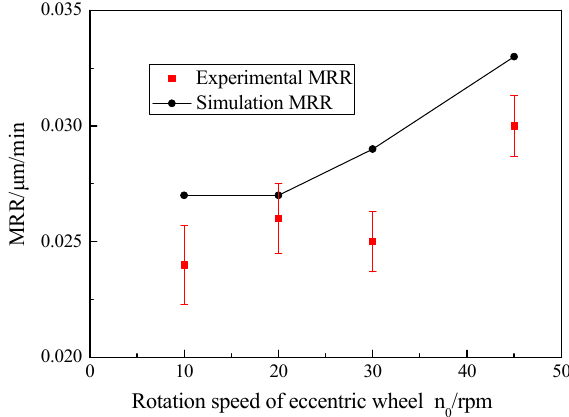
Figure 11. Effect of eccentric wheel rotation speed on MRR.